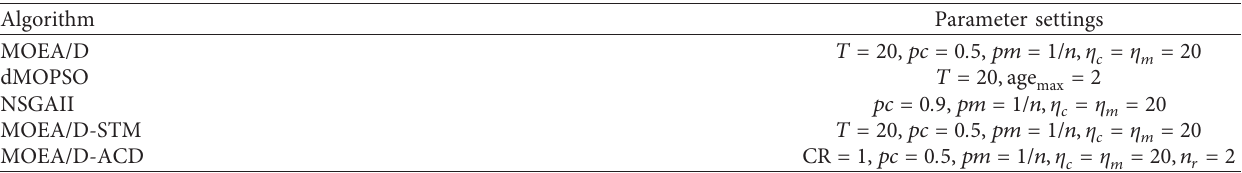
Table 1: Parameter settings of all compared algorithms. Algorithm Parameter